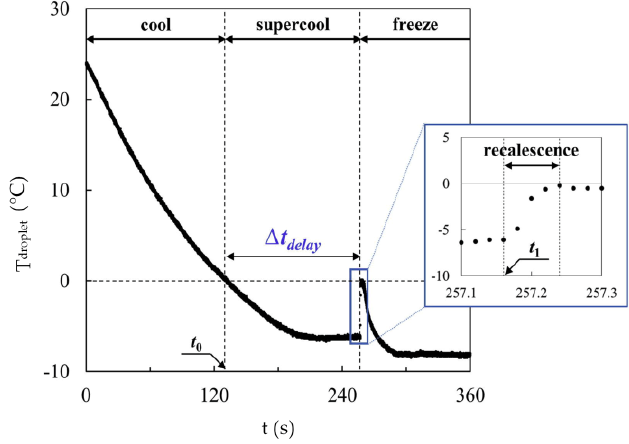
Figure 3. The change of a condensed water droplet temperature on a cold surface [60].